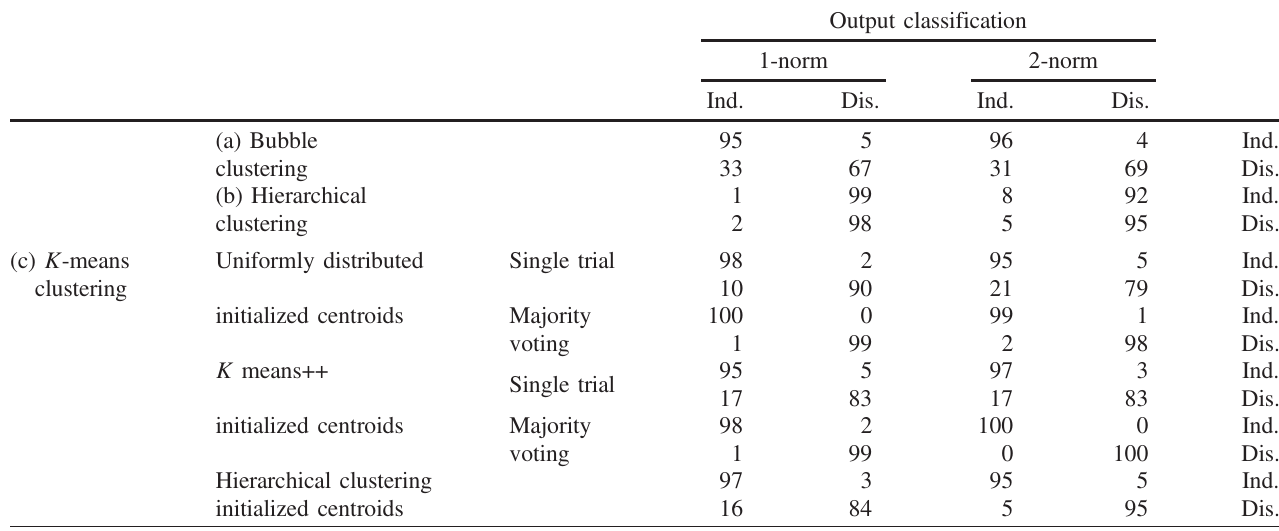
TABLE II. Confusion matrix for different clustering techniques and fixed unitary evolution [tuning stage, step (i)]. Success percentages of the compatibility tests for all the different clustering techniques studied, i.e., bubble clustering, hierarchical clustering, and K -means clustering. The latter algorithm is investigated in its standard version and initialized by K means++ or a preliminary run of hierarchical clustering [57]. Then, majority voting is performed on the nondeterministic versions of K means. The reported success percentages are evaluated through numerical simulations by keeping the unitary evolution operator fixed. This choice is motivated by the need of tuning the different algorithms in order to subsequently classify new data